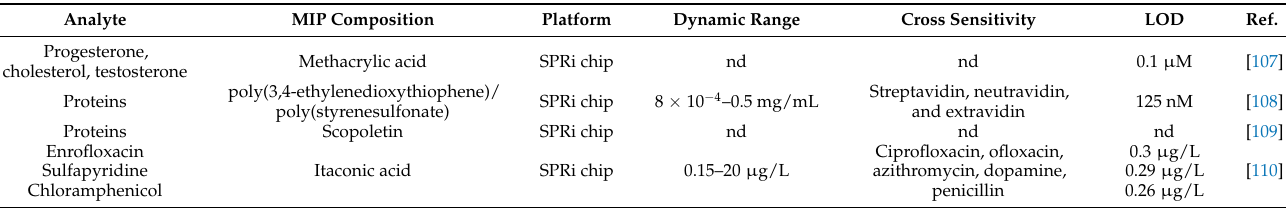
Table 5. Summary of the MIP-based SPR imaging (SPRi) sensors described in Section